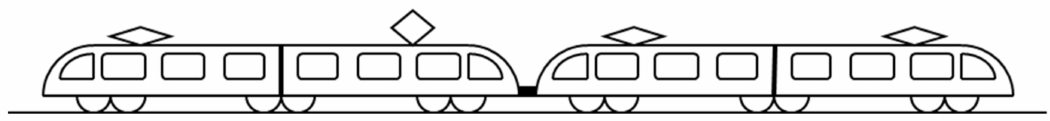
Figure 1. Rolling stock configuration 1: locomotive hauling passenger carriages.